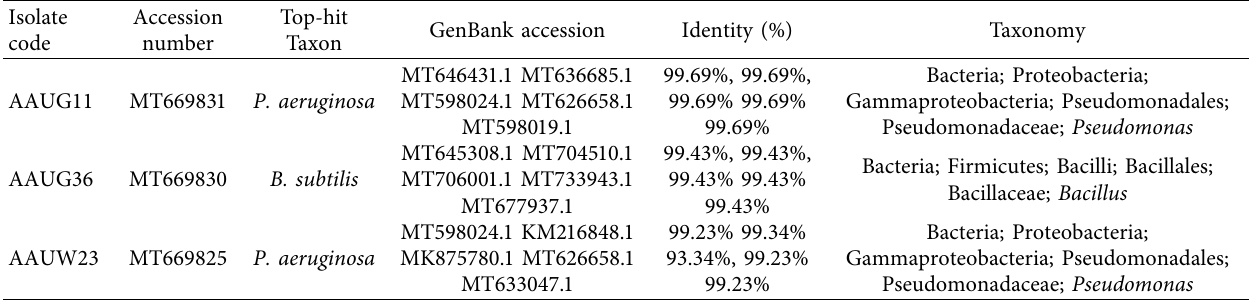
Table 3: Phylogenetic affiliation of 16S rRNA partial sequences of three bacterial